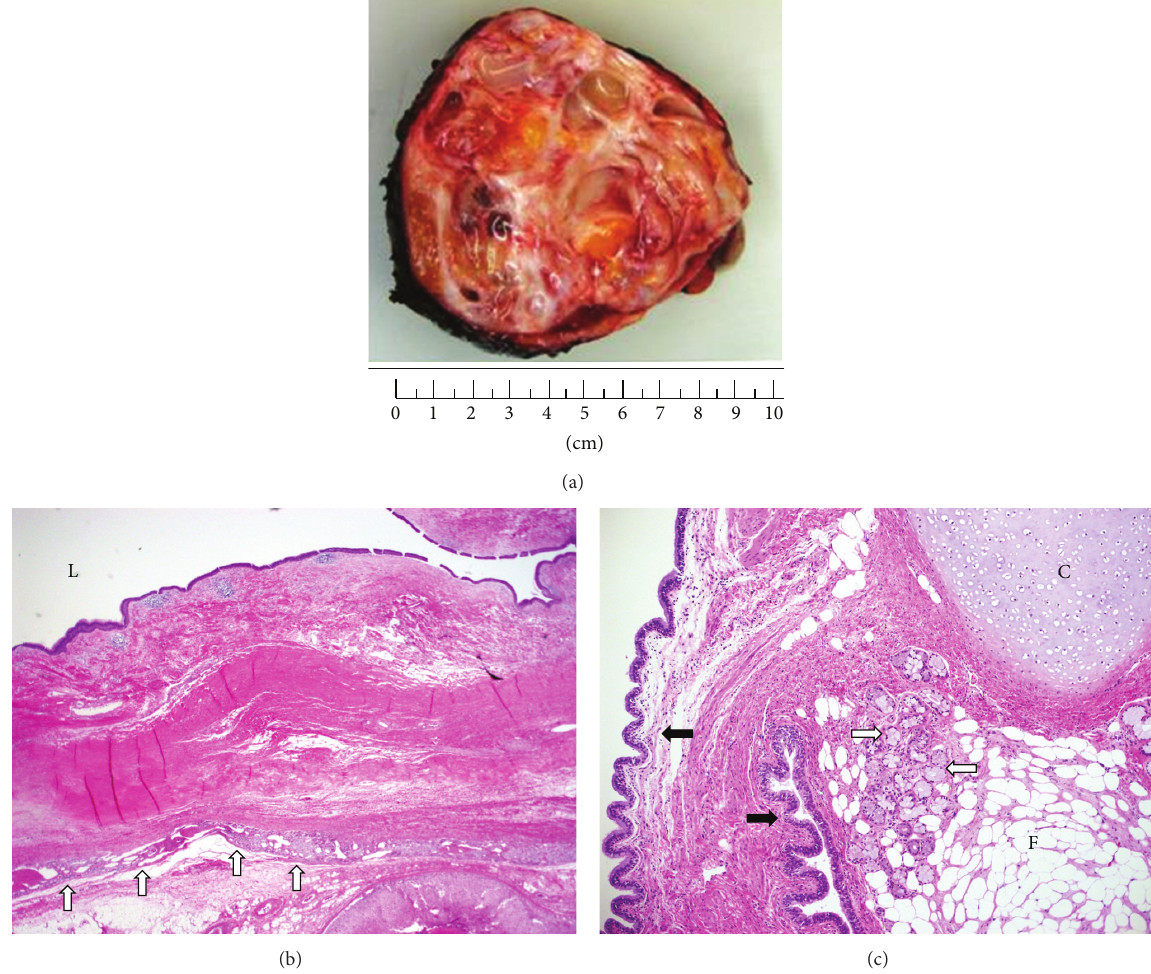
Figure 2: Mature (benign) cystic retroperitoneal teratoma in the region of left adrenal gland. (a) Grossly, cut-section of the resected mass revealed multilocular cystic spaces, whitish-gray walls, scattered yellowish adipose tissues, mucus secretions, and areas of calcifications. (b) Hematoxylin & Eosin (H&E stain), × 20 magnification: a scanning magnification view of the lesion depicting its relationship with the adrenal cortex (open arrows). The lumen [L] is lined by respiratory columnar epithelium. (c) Hematoxylin & Eosin (H&E stain), × 40 magnification: a low magnification image of another cystic space lined by mucous-secreting epithelium (solid arrows). The wall is formed by cartilage tissues [C], fat (adipose) tissues [F], and salivary gland tissues (open